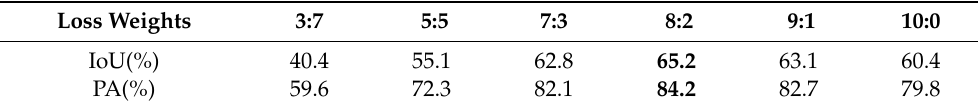
Table 2. Performance of different loss weights on the test